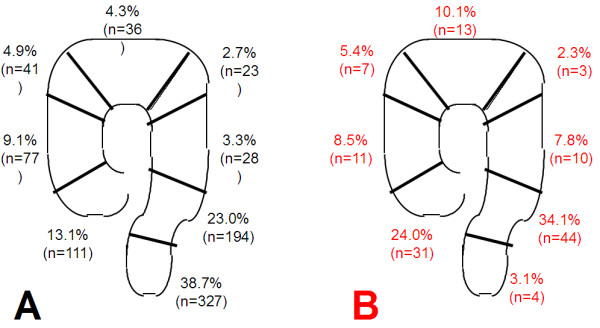
Percentages of tumors at each location for the elective and emergency surgery cases. The percentage of tumors was calculated for each location (cecum, ascending colon, hepatic flexure, transverse colon, splenic flexure, descending colon, sigmoid, and rectum) for (A) the elective and (B) emergency surgery cases. Cases in the appendix were omitted from both groups (n = 1 and n = 2 respectively).